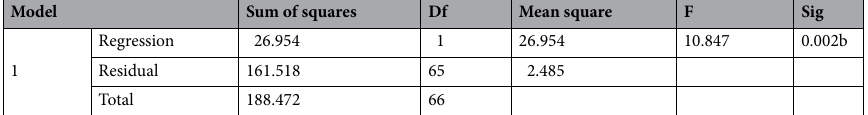
Table 6. ANOVA table for stepwise regression model adjusted for the dependent variable T score of the lumbar spine. a. Dependent Variable: T score lumbar spine. b. Predictors: Body mass index (kg/m 2 ).